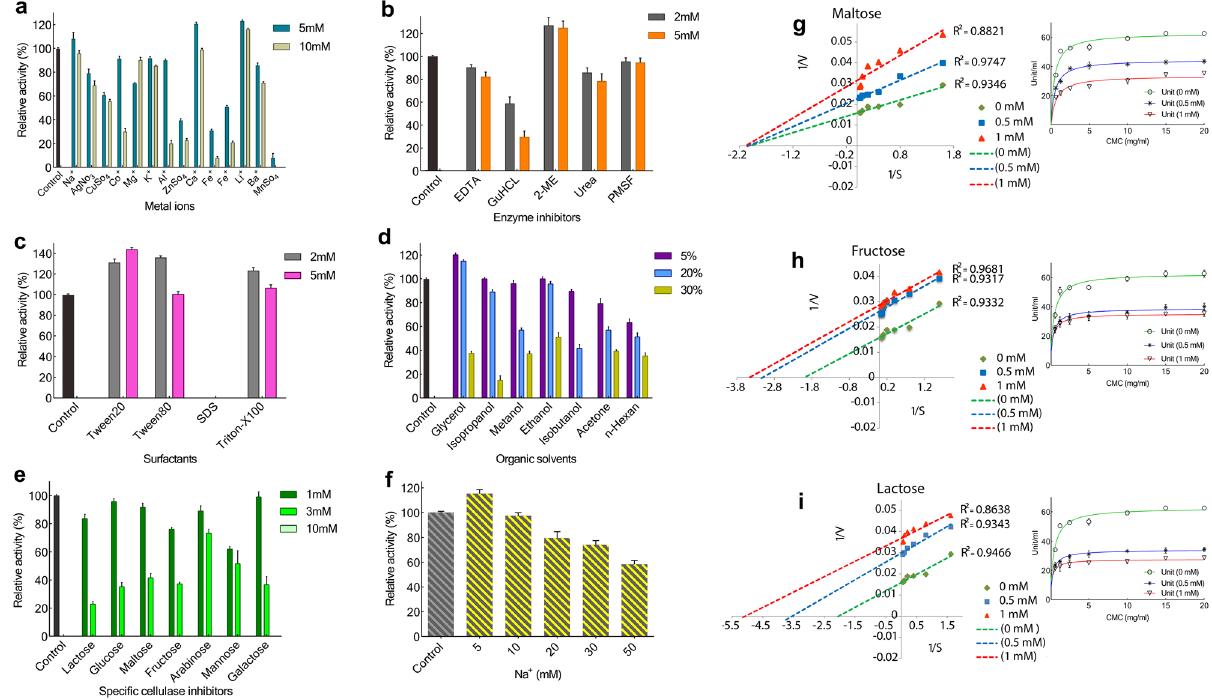
Figure 8. Effect of effectors on the recombinant CelC307. Effect of different ( a ) metal ions, ( b ) enzyme inhibitors, ( c ) surfactants, ( d ) organic solvents, ( e ) specific cellulase inhibitors, and ( f ) concentrations of Na + on the CelC307 activity. The graphs were plotted by using GraphPad Prism V.8. Lineweaver–Burk plot of ( g ) maltose, ( h ) fructose, and ( i ) lactose. Lineweaver–Burk plots were drawn in Excel 2016. Each point represents the mean of three experiments. The cellulolytic activity was measured in the absence and presence of